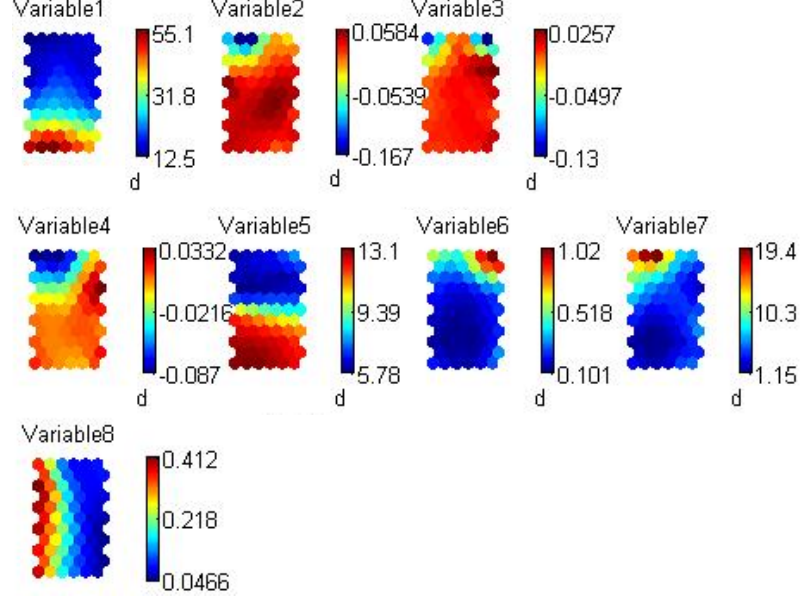
Figure 4. Map of features.